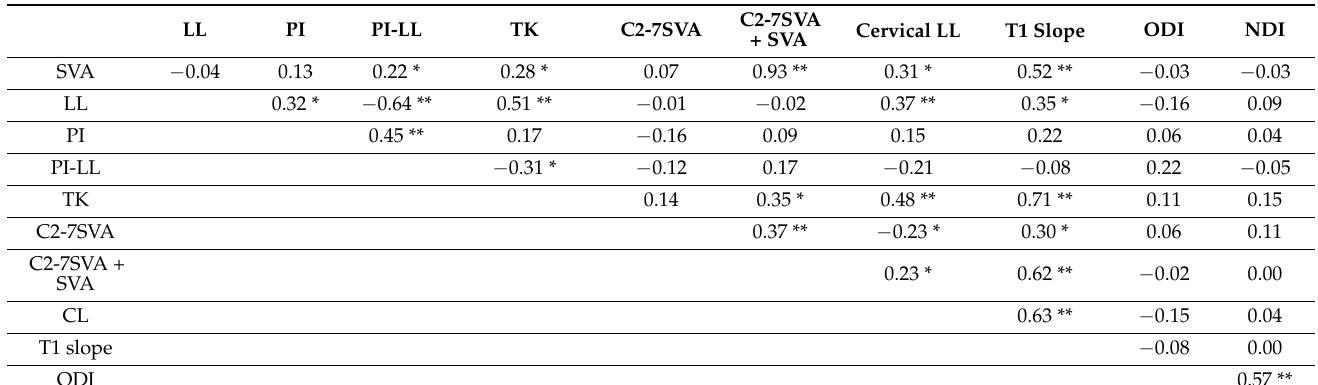
Table 4. Association among radiographic parameters using Spearman’s correlation among non-